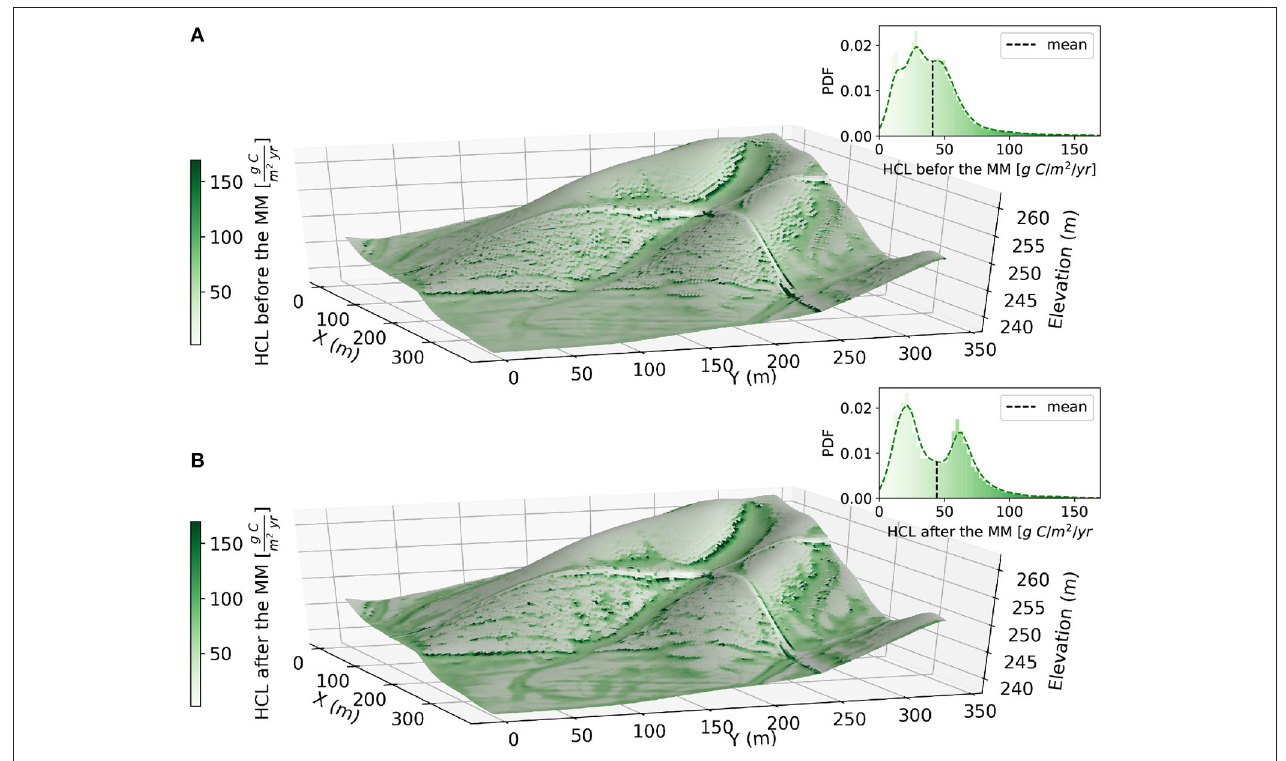
FIGURE 8 | Comparison of the spatial distribution of vertically integrated HCL before and after the mechanical-mixing. Annual mean values of the HCL between (A) years 85–90 and (B) years 140–145 corresponding to dynamic steady-states before and after mechanical-mixing, respectively. The probability distribution function for each plot is shown in the